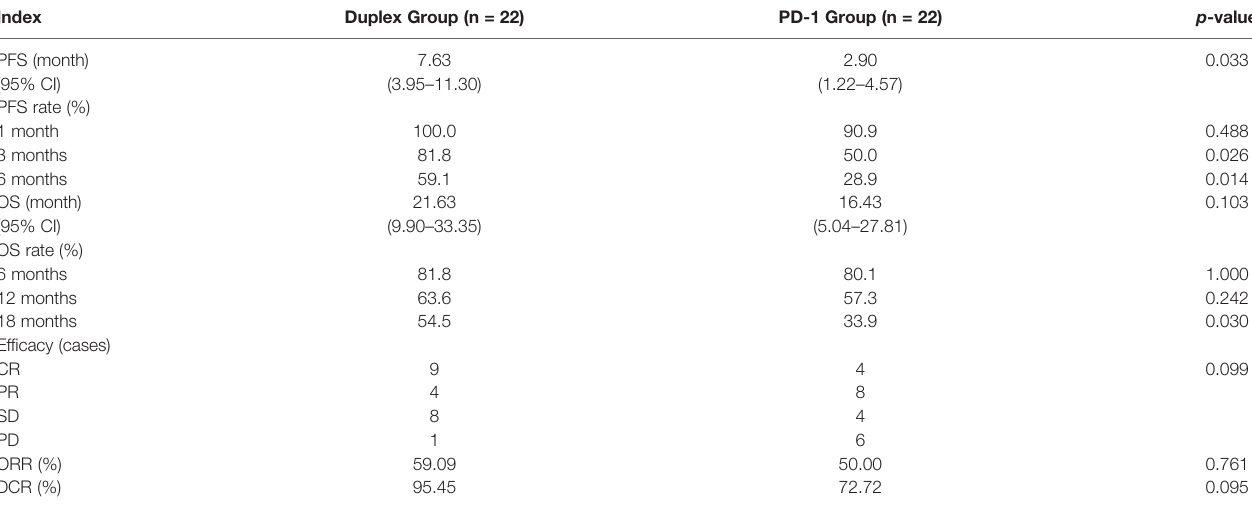
TABLE 2 | Survival analysis and therapeutic effectiveness between the two study groups.